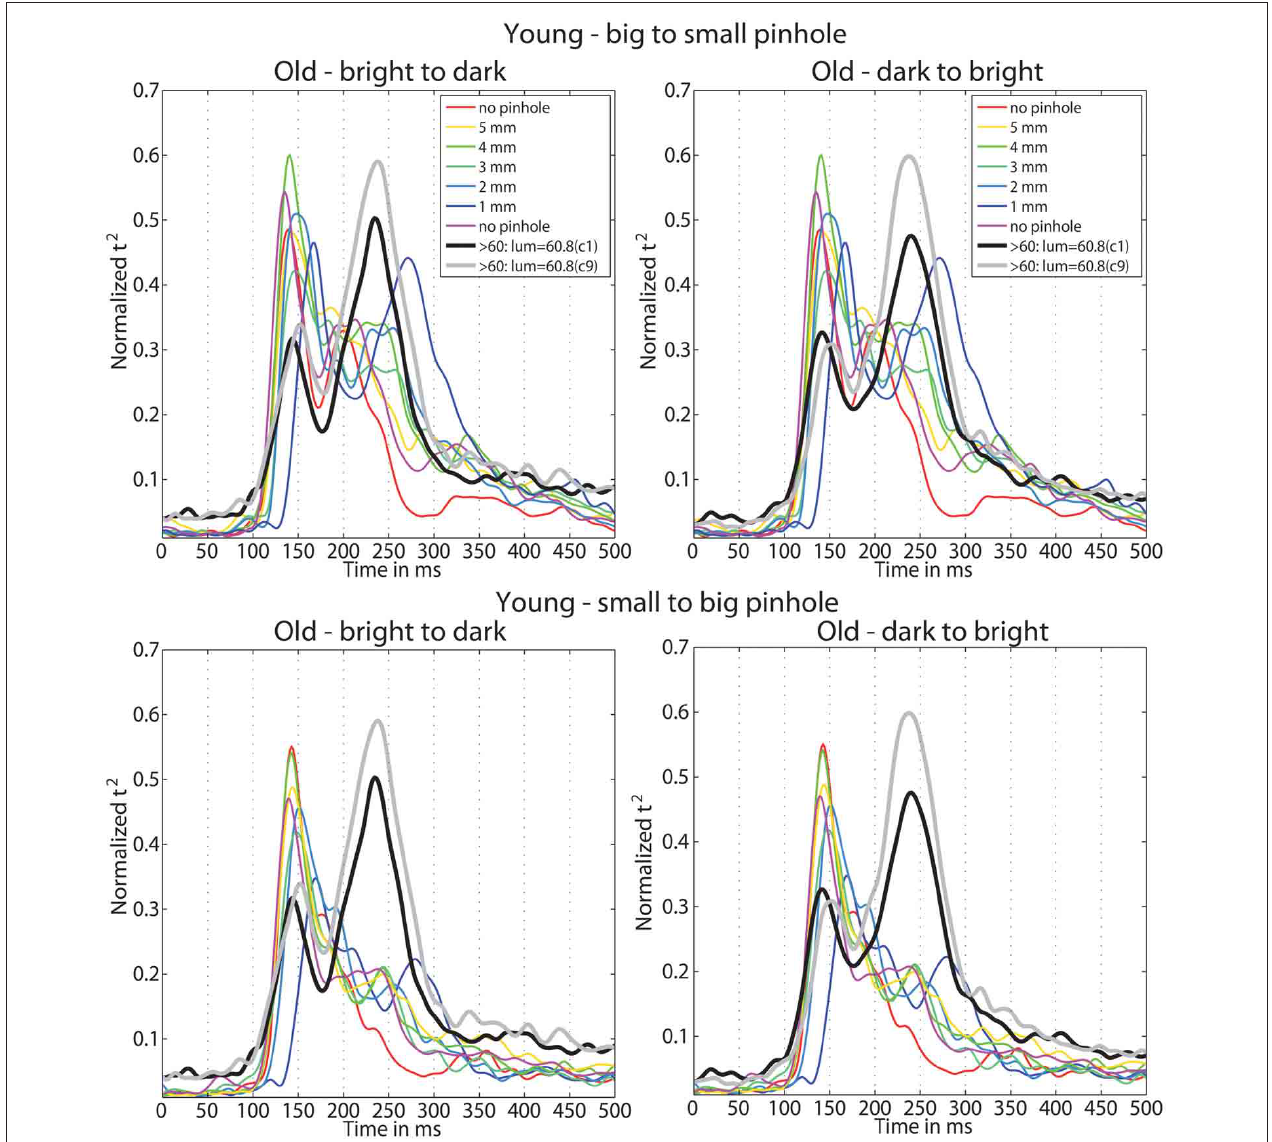
of old subjects from the luminance experiment, in the two conditions with the highest luminance 60.8cd/m 2 : condition 1 (c1) plotted in black, and condition 9 (c9) plotted in